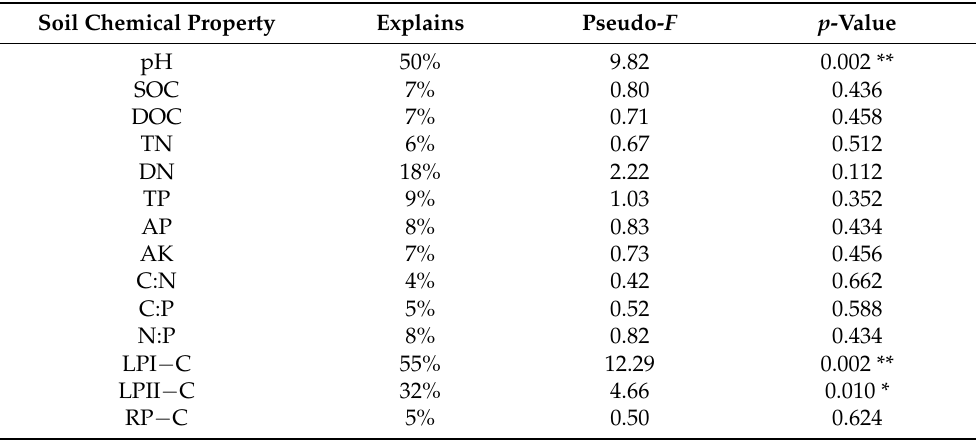
Table 2. Results of the permutation test of the redundancy analysis (RDA), estimating potential sig- nificant relationships between soil chemical properties with enzyme activities and their stoichiometry. The results are based on 999 permutations.